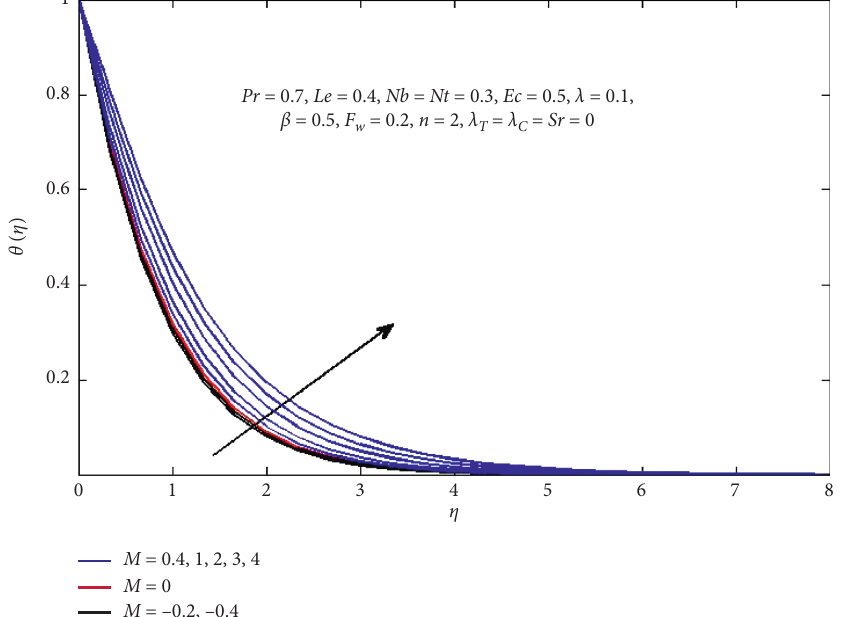
Figure 12: Variation of temperature θ concerning η with various values of M